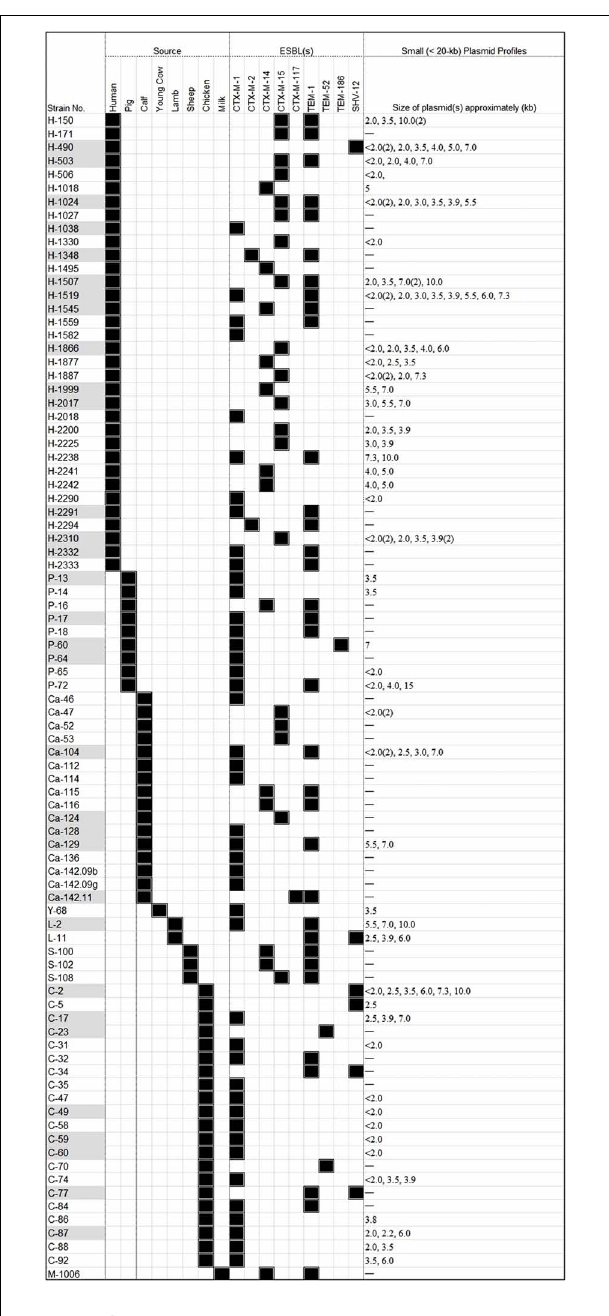
FIGUREA1 |A heat-map summary of the original 87 ESBL-positive E. coli isolates previously reported from healthy food-producing animals and humans in Switzerland. Black squares shown indicate a feature present in that isolate denoting its original source and the ESBL marker(s) detected; and white squares denote features that are lacking in the corresponding bacterial isolate.The approximate sizes of small plasmids are also showing in separate columns.The symbol “–” signifies no small ( < 30-kb) plasmid in the corresponding strain. Isolate numbers denoted by the grayed boxes on the left of the heat-map indicate those bacteria that were selected for conjugation experiments and S1-nuclease-based PFGE studies (as described in Figure 1